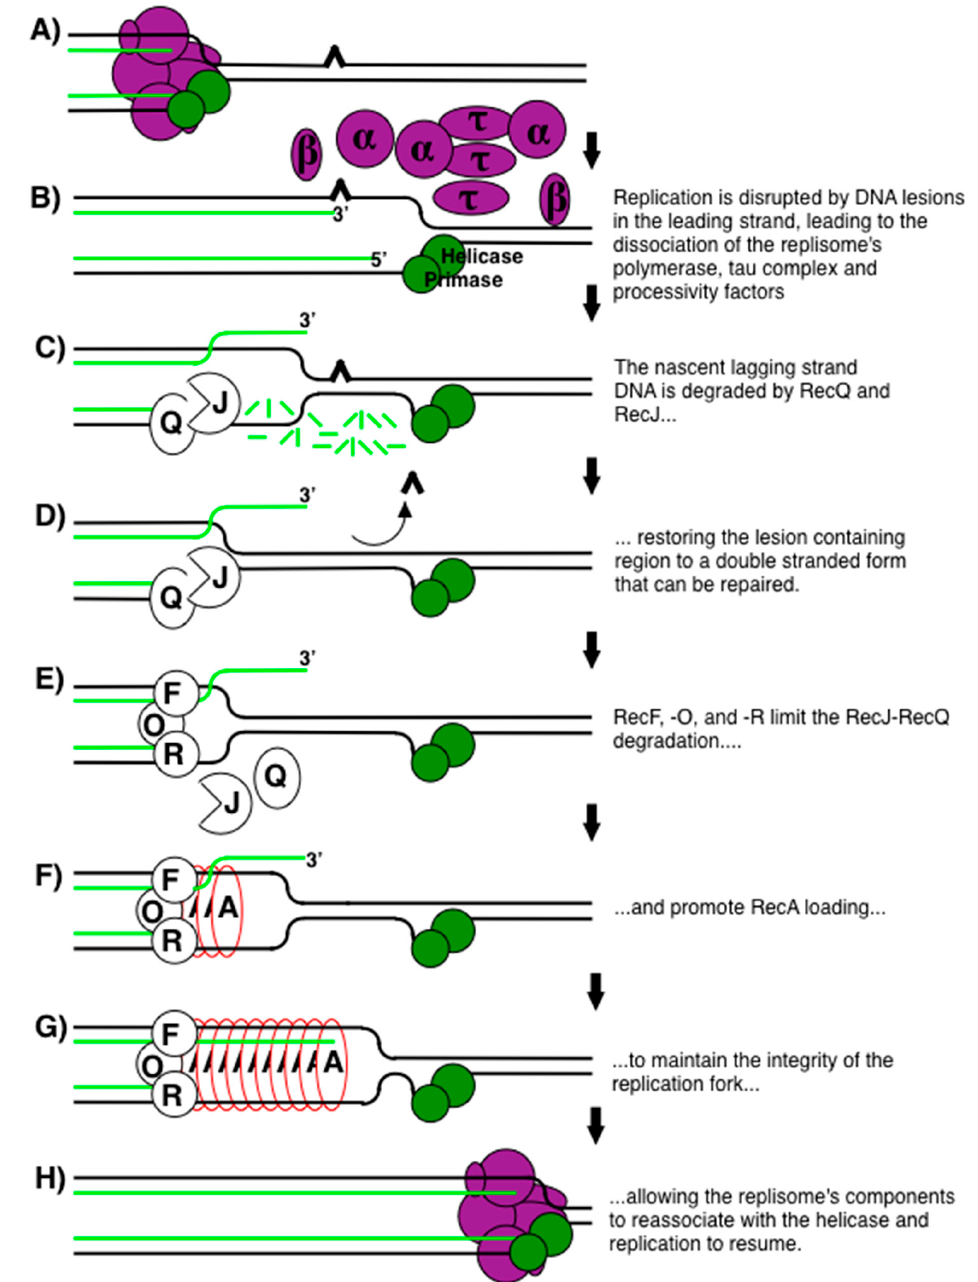
Figure 3. Model of how the RecF pathway restores replication following disruption. ^, pyrimidine dimer; purple subunits, the tau complex, DNA polymerase III, and processivity factors of the replisome; green subunits, helicase-primase; Q, RecQ; J, RecJ: F, RecF; O, RecO; R, RecR; A, RecA. ( A – H ): Different RecF pathway gene products.